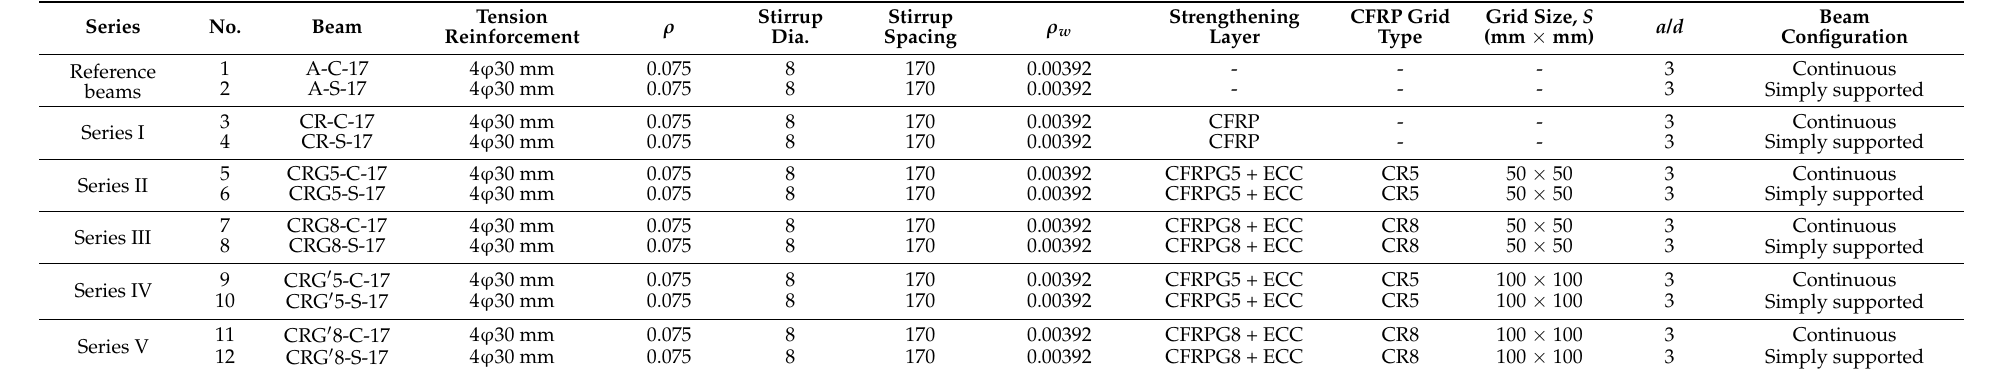
Table 3. Details of the beams (adapted with permission from [37]; copyright 2006 American Concrete Institute). (Unit: